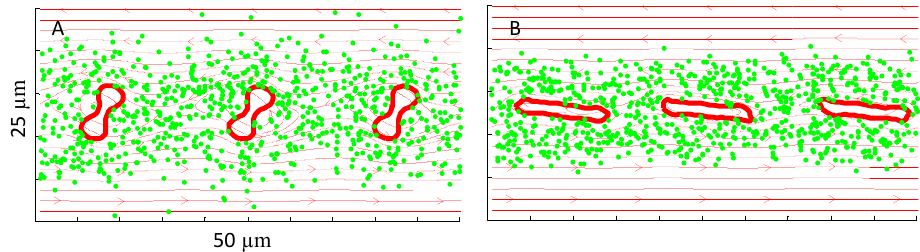
Figure 3. Interaction between nanoparticle (NP) and red blood cell (RBC) at shear rates of ( A ) 40 s − 1 (RBC tumbling) and ( B ) 200 s − 1 (RBC tank treading). The bold red lines outline the RBC membranes, while the green markers denote NPs. Flow streamlines are shown in the background.